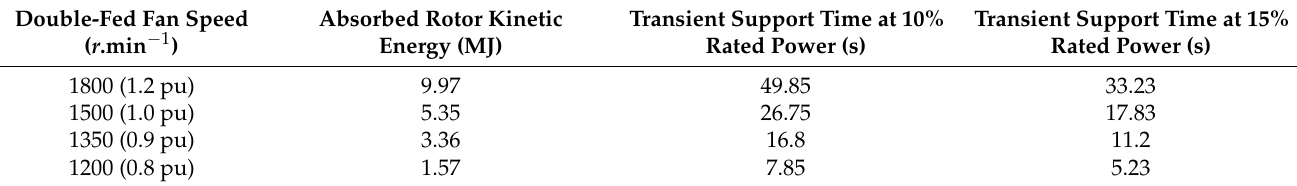
Table 1. Transient support capability of DFIG at different rotor